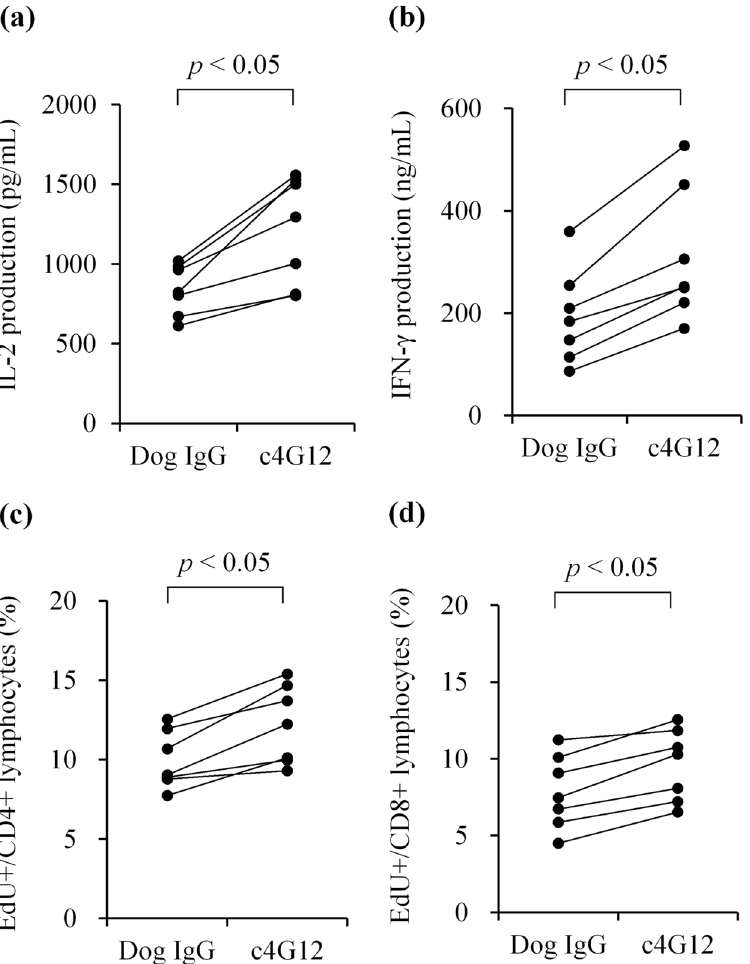
Figure 2. Enhancement of cytokine production and cell proliferation of dog peripheral blood mononuclear cells by c4G12 treatment. Dog peripheral blood mononuclear cells ( n = 7) were obtained from healthy beagle donors and stimulated by 5 μ g/mL staphylococcal enterotoxin B in the presence or absence of 20 μ g/mL c4G12. Dog IgG was used as a control antibody. For evaluation of cytokine production, the culture supernatant was harvested on day 3, and concentration of ( a ) IL-2 or ( b ) IFN- γ was measured by ELISA. To evaluate cell proliferation, nucleotide analogue 5-ethynyl-2 ′ -deoxyuridine (EdU) was added to the medium on day 2, and cells were harvested after incubation for another 2 h. The lymphocyte population was gated by forward scatter and side scatter, and the incorporation of EdU in ( c ) CD4 + or ( d ) CD8 + cells was measured by a flow cytometer. Statistical analysis was performed with a Wilcoxon signed rank-sum